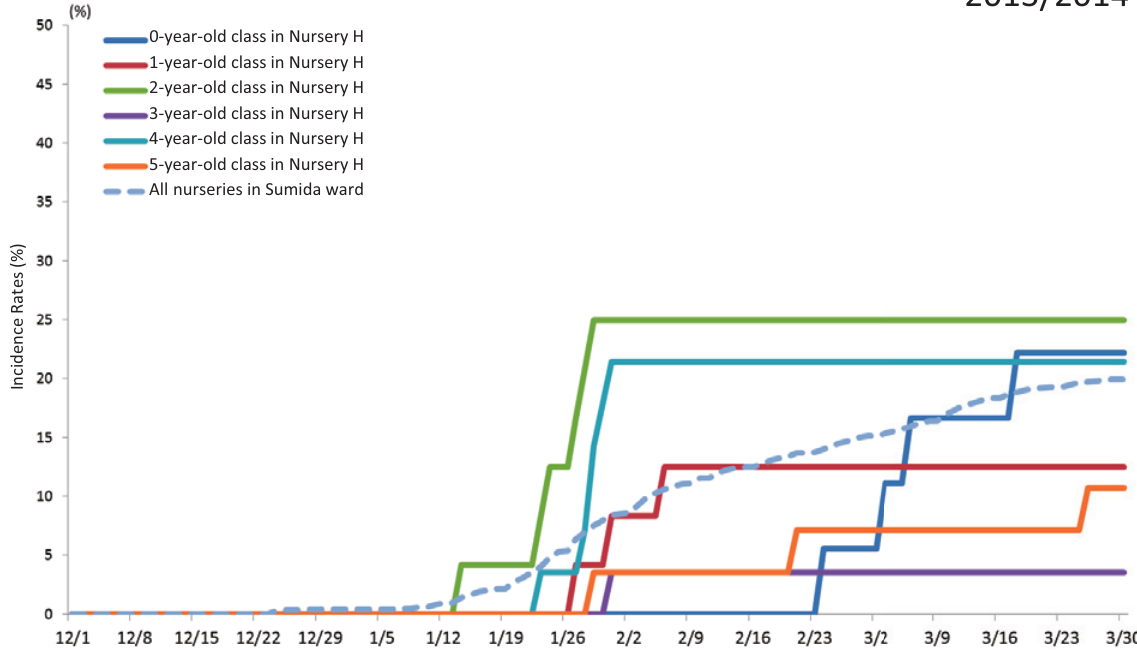
F i g . 2 D y namics of incidence rates of infl u enza b y a g e in N u rser y H compared w ith all n u rseries in S u mida W ard in the 2013/2014 season. Data of all elementar y and j u nior hi g h schools are not a v ailable beca u se schools in S u mida w ard had not y et participated in NaSASS y in 2013.